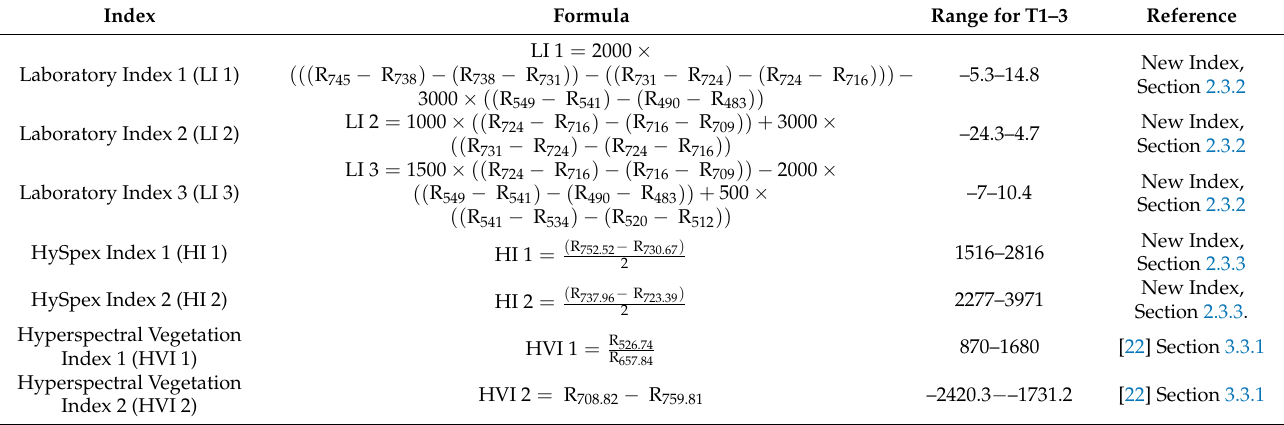
Table 2. Laboratory, HySpex and hyperspectral vegetation indices (R = reflectance). The laboratory indices (LI) and HySpex indices (HI) are new indices and are presented in more detail in Sections 2.3.2 and 2.3.3. The hyperspectral vegetation indices (HVI) have been adapted from [22] (see Section 3.3.1). For all indices the reflectance [%] was used as input and only for HI and HVI the output was multiplied by 1000 [% × 1000], which leads to certain ranges for T1–3 (see second last